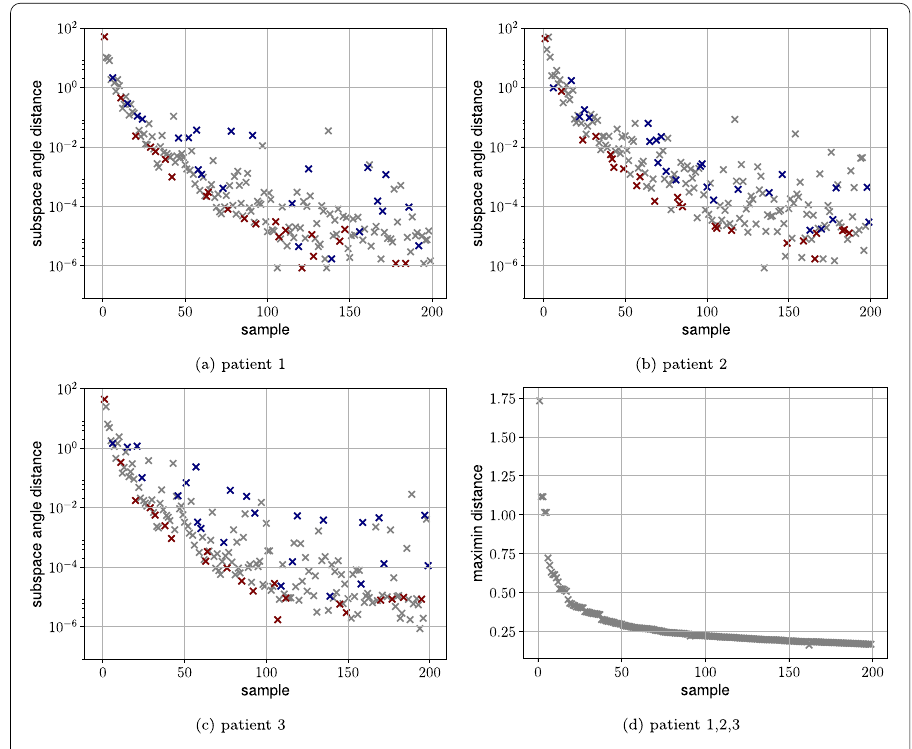
Fig. 7 a – c Decay of the SAD. Dark red points correspond to parametric configurations in the ( + + + )-octant of the parameter domain, while blue points correspond to parametric configurations in the ( − − − )-octant of the parameter domain. d Decay of MMD with every newly set point